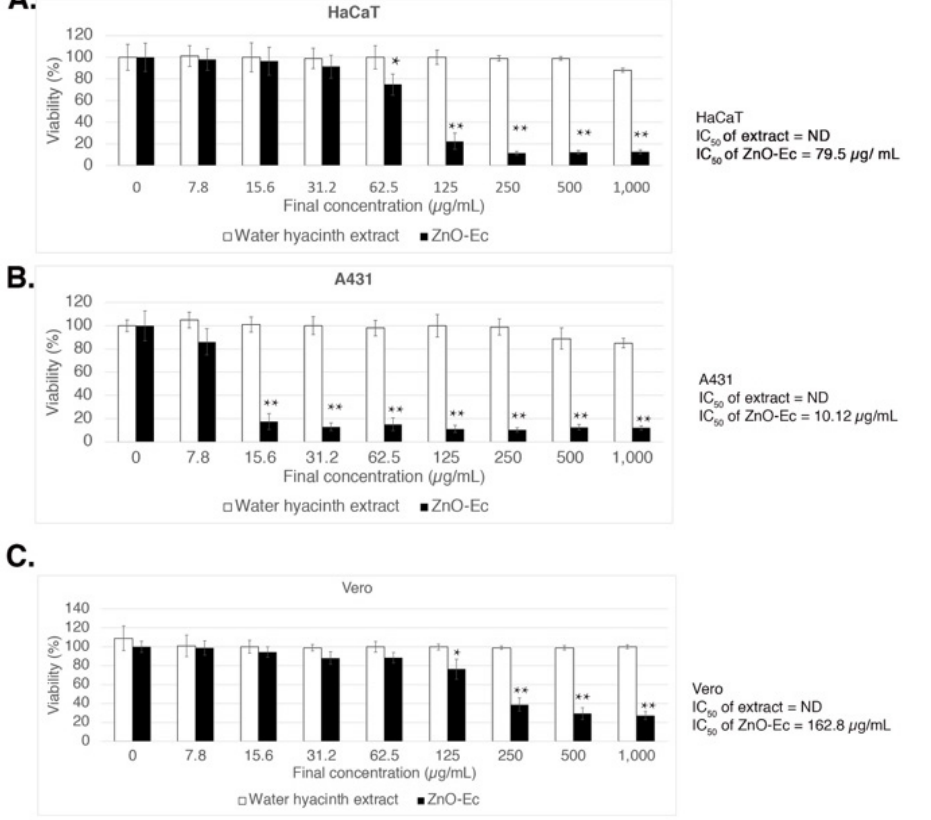
Figure 8. Cytotoxicity effects of ZnO-Ec and water hyacinth crude extract in vitro. ( A ) HaCaT, ( B ) A431, and ( C ) Vero. ND stands for not determined. IC 50 values were shown as indicated. The results are presented as mean ± SD of quadruplicate data from three independent experiments. * p < 0.05, ** p < 0.01 (using ANOVA, Tukey’s test) were used to indicate significant differences between the samples.